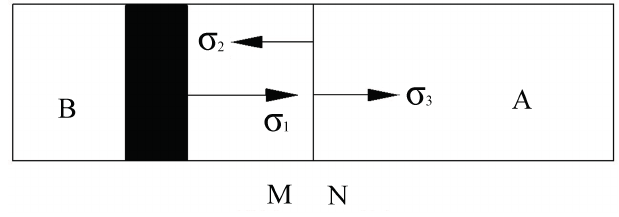
Figure 8. Reflection and transmission of elastic